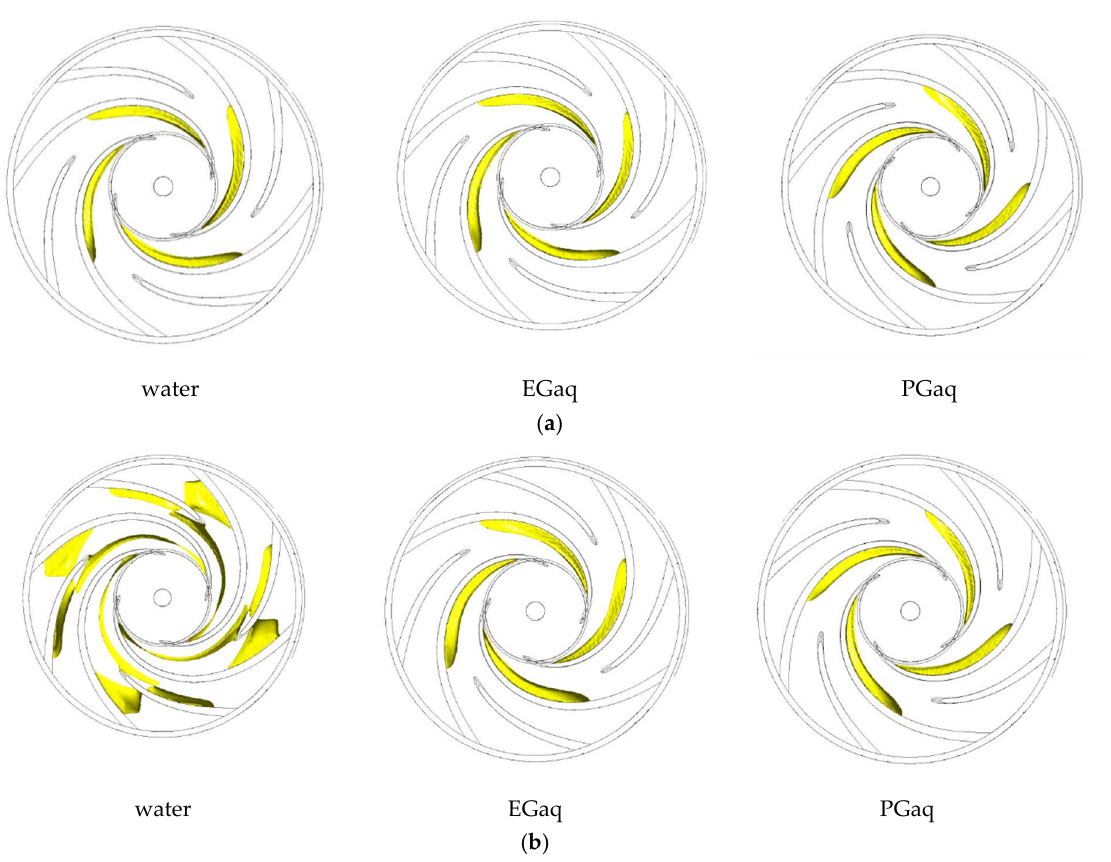
Figure 18. Iso-surface of cavitation distribution in the impeller of cylindrical blades. ( a ) 20 °C at 0.3